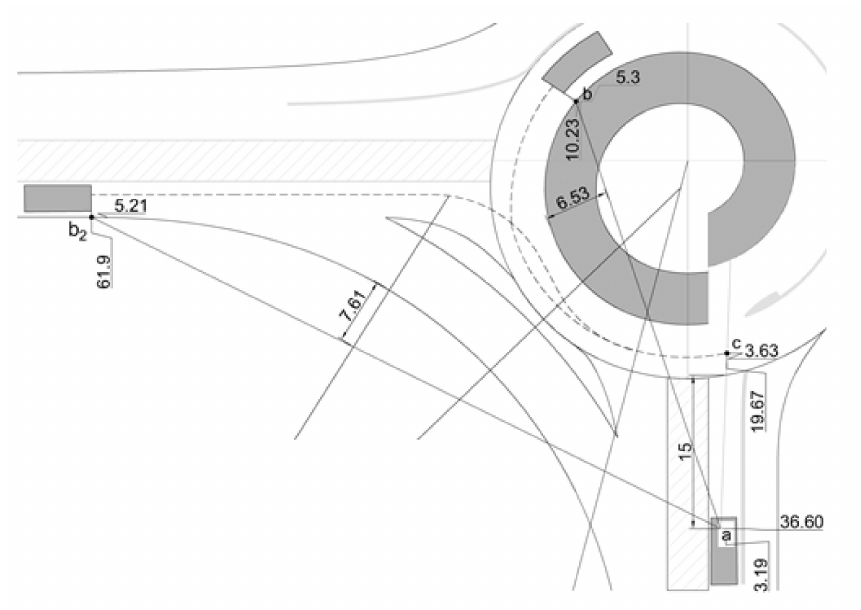
Figure 6. Model validation.